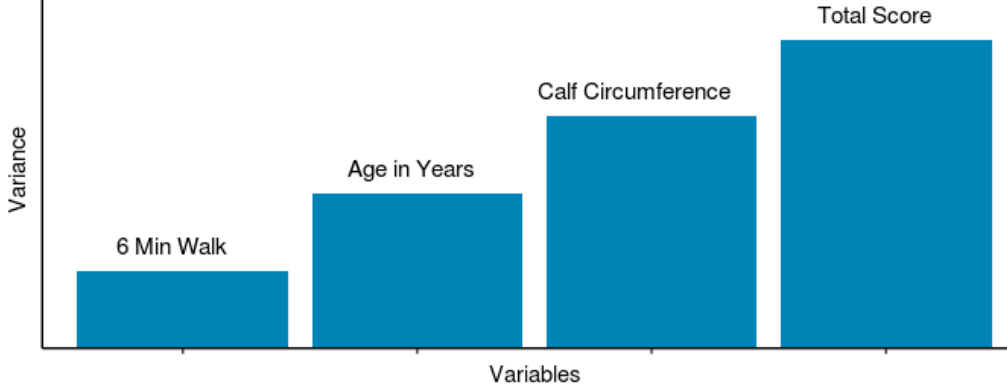
Figure 5. Predictive variables: final ML model predictor variables with relative variance contribution to PAD.